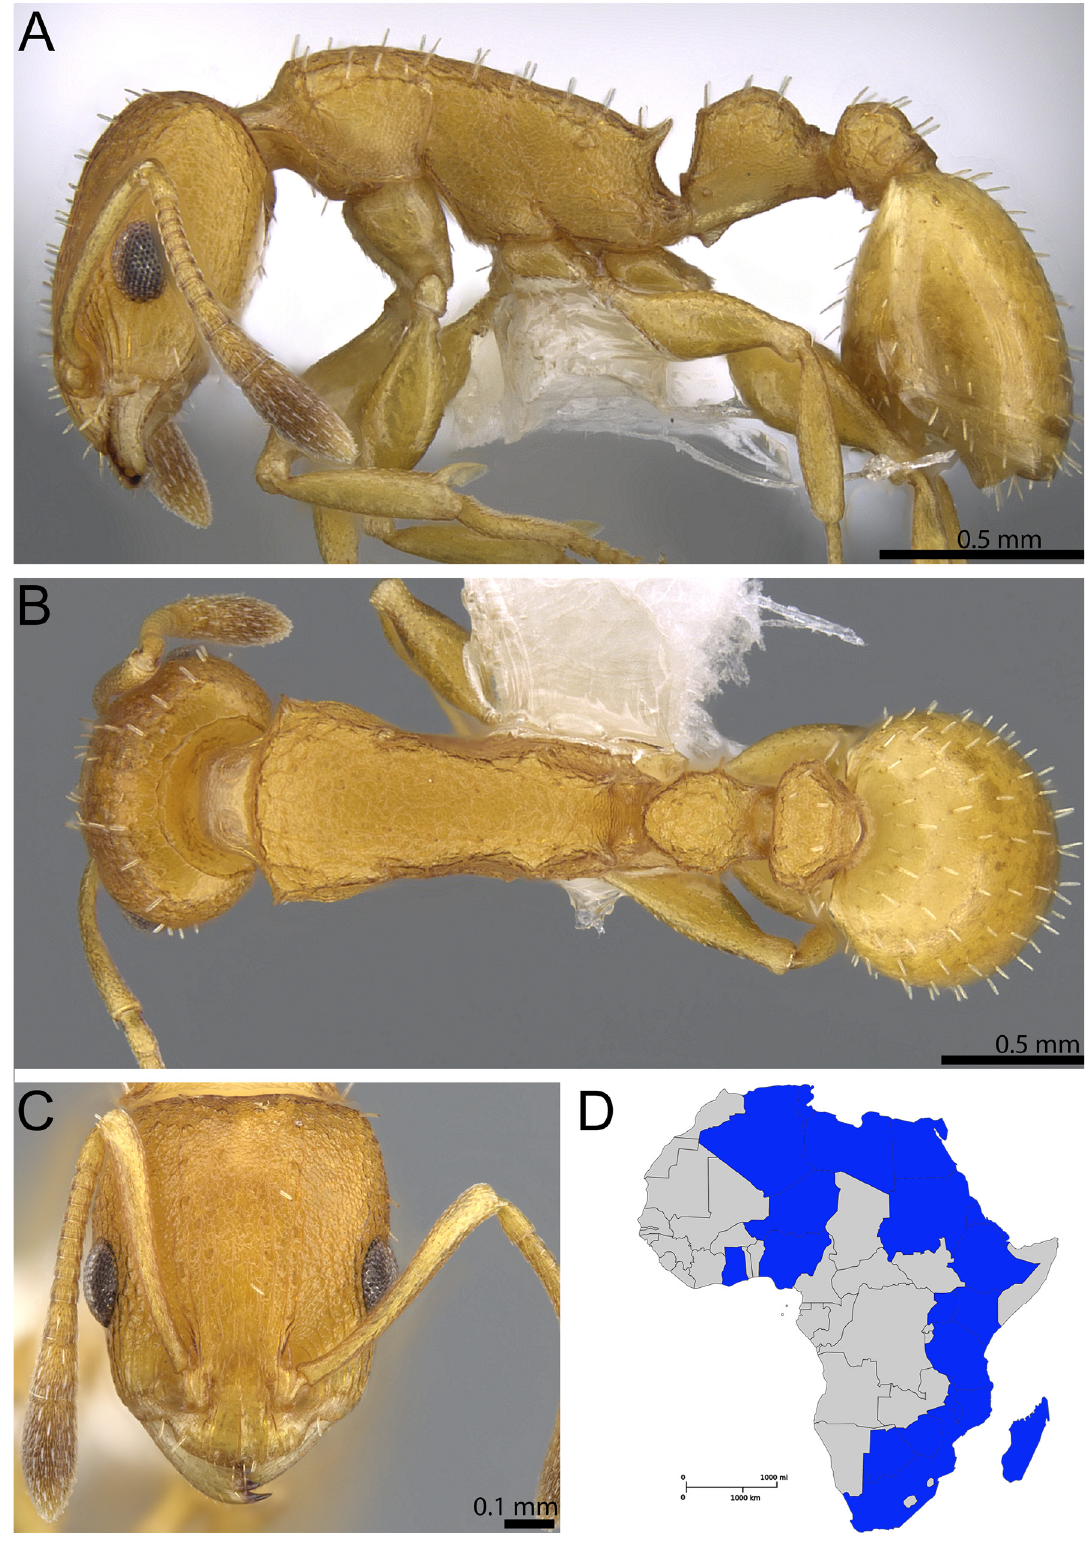
Fig. 14. Nesomyrmex angulatus (Mayr, 1862) (CASENT0922010). A . Body in profile view. B . Body in dorsal view. C . Head in full-face view. D . Map of Africa and Madagascar showing currently known